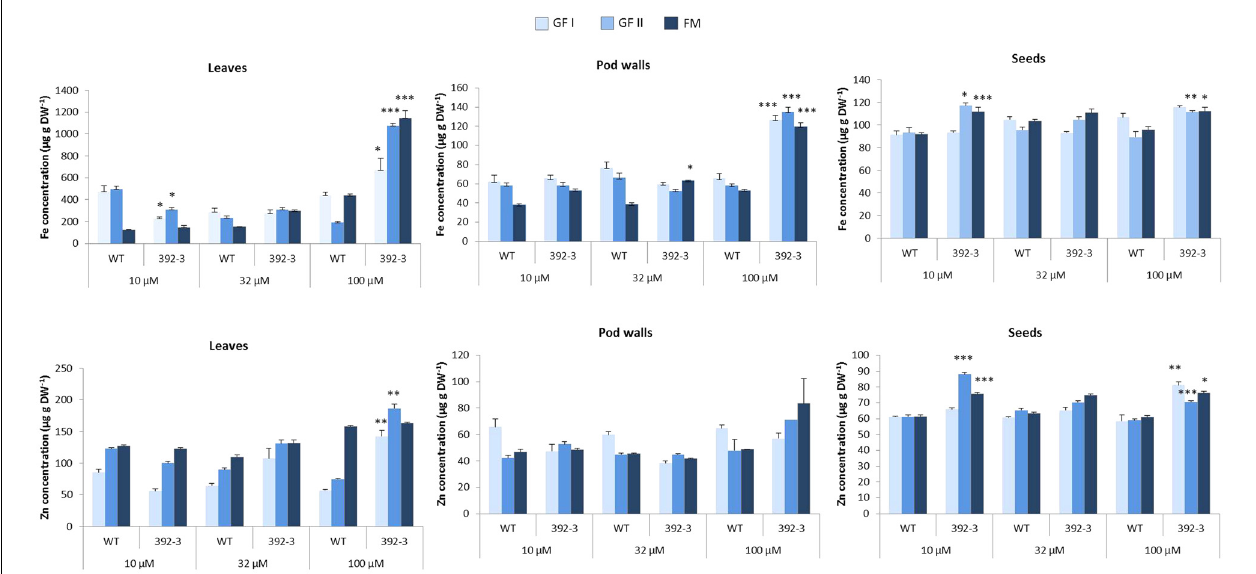
FIGURE 6 | Fe and Zn concentration ( μ g g − 1 ) in leaves, pod walls and seeds ofWT and transgenic 392-3 soybean plants grown in hydroponic conditions with 10, 32, or 100 μ M Fe (III)-EDDHA. Tissues were harvested at two grain filling stages (GF I and GF II) and at full maturity (FM). Asterisks